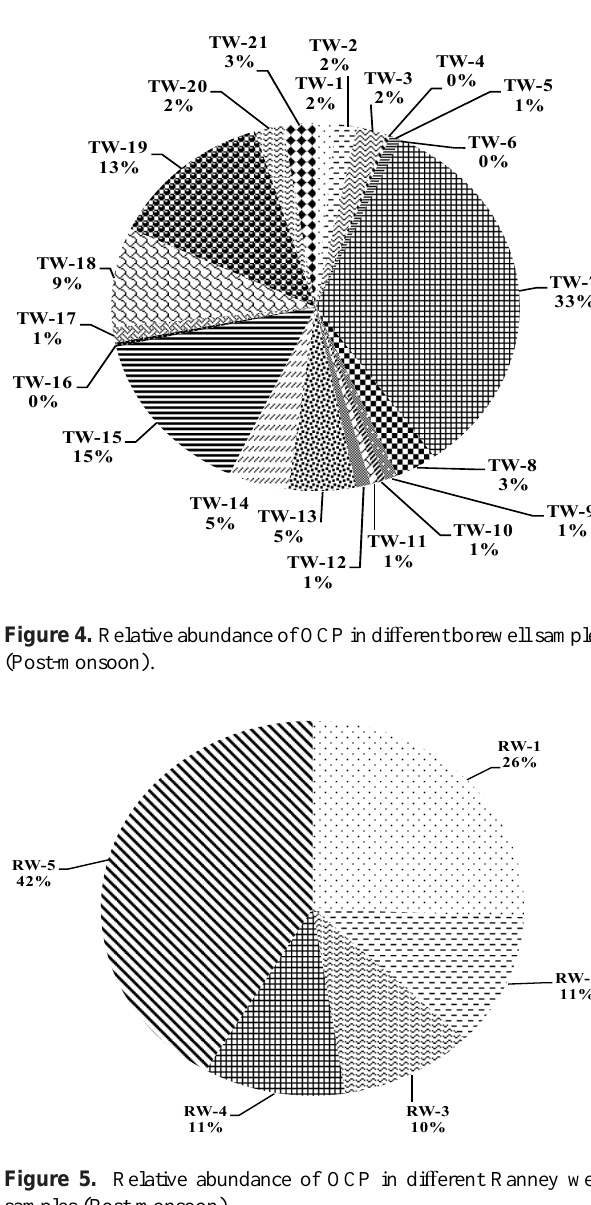
Figure 7. Comparison of borewell water quality with respect to various limits